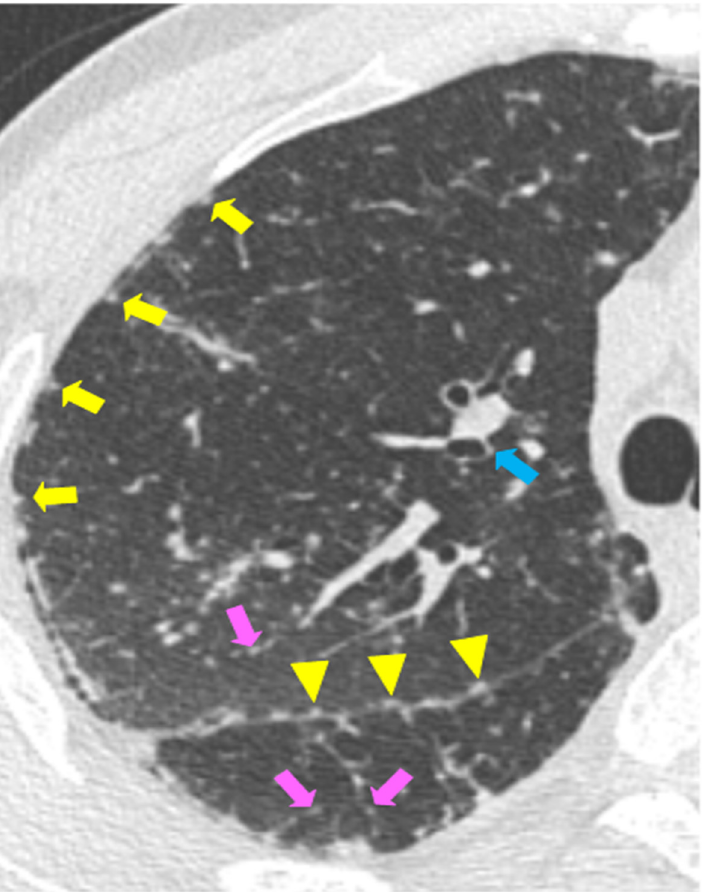
Figure 1. Distribution of micronodules in sarcoidosis. The axial HRCT scan in a patient with pulmonary sarcoidosis shows the typical perilymphatic distribution of micronodules along the subpleural interstitial space (yellow arrows), along the fissure (yellow arrowheads), and interlobular septa (pink arrows). The blue arrow shows the peribronchovascular distribution.